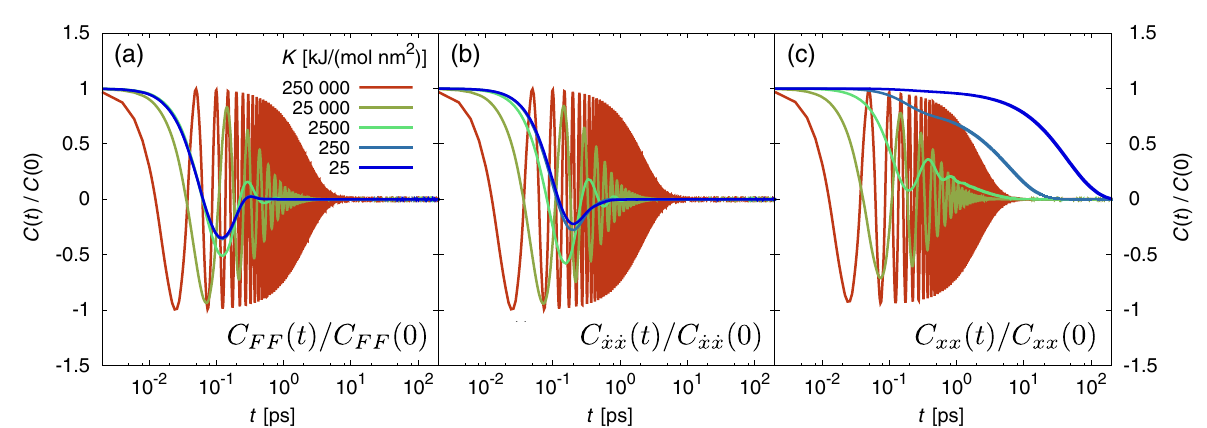
ð t Þ =C ð 0 Þ , C ð t Þ =C ð 0 Þ , and C ð t Þ =C ð 0 Þ for the system with the size _ x _ x _ x _ x FF FF xx xx